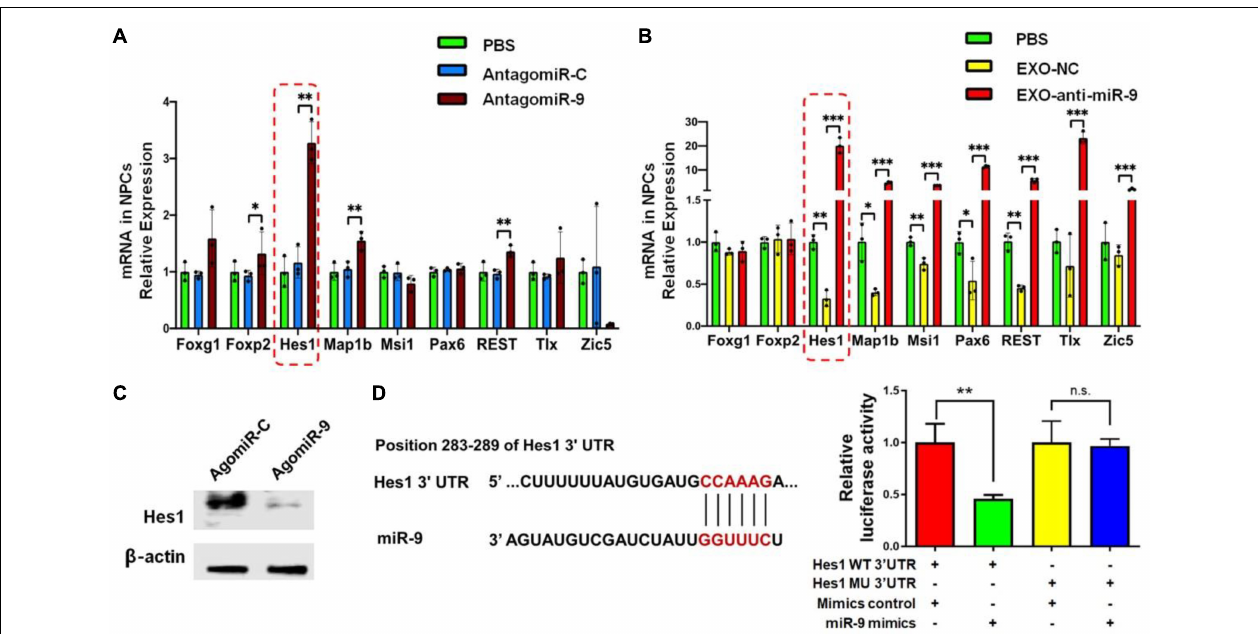
FIGURE 7 | Hes1 expression is negatively regulated by miR-9 in NSCs. (A) The expression levels of transcripts corresponding to known targets of miR-9 in NSCs transfected with either antagomiR-9 or antagomiR-C were determined by RT-qPCR analysis. (B) The expression levels of transcripts corresponding to known targets of miR-9 in NSCs co-cultured with either EXO-antagomiR-9 or EXO-antagomiR-C were determined by RT-qPCR analysis. (C) Representative western blotting results showing the expression of Hes1 and β -actin proteins in either agomiR-C- or agomiR-9-transfected NSCs. (D) The predicted consequential pairing of Hes1 3 (cid:48) UTR (top) and miR-9 (bottom) on the TargetScan website (left). Repression of luciferase activities by the Hes1 3 (cid:48) UTR were dependent on miR-9 (right). Firefly luciferase activities were normalized to the internal control, Renilla luciferase activities. Data were represented as mean ± SE from three independent experiments. ∗ , ∗∗ , and ∗∗∗ denote p < 0.05, p < 0.01, and p < 0.001, respectively. ns, non-significance in comparison to